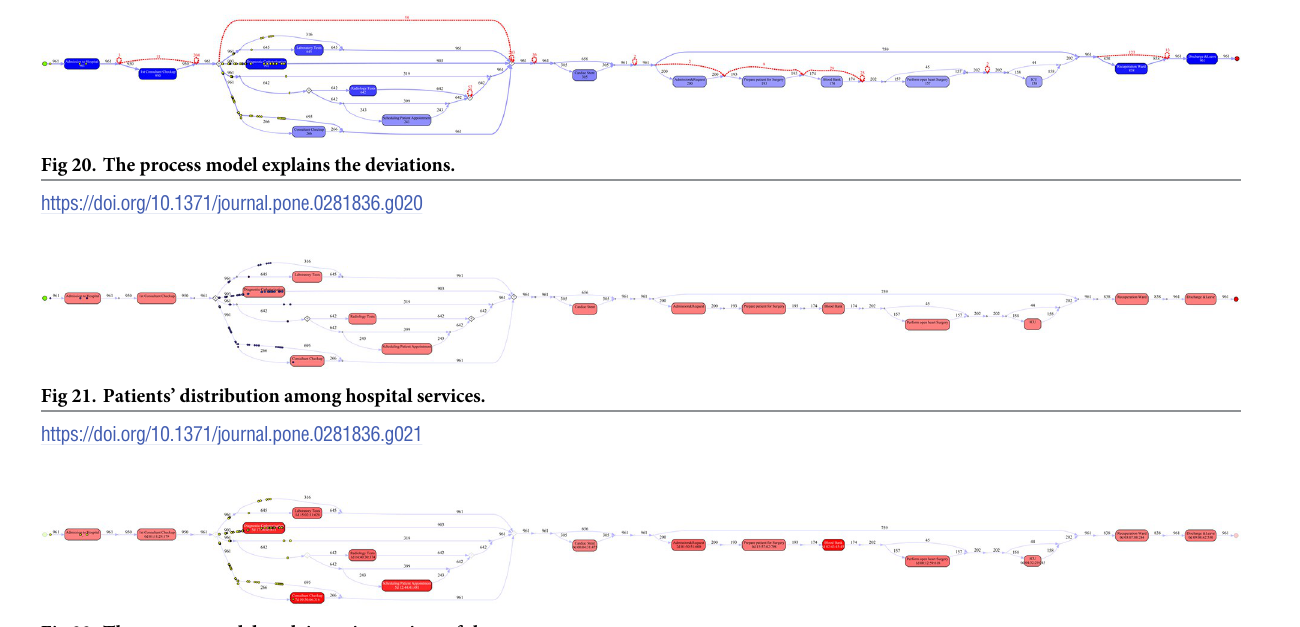
Fig 22. The process model explains sojourn time of the resources.